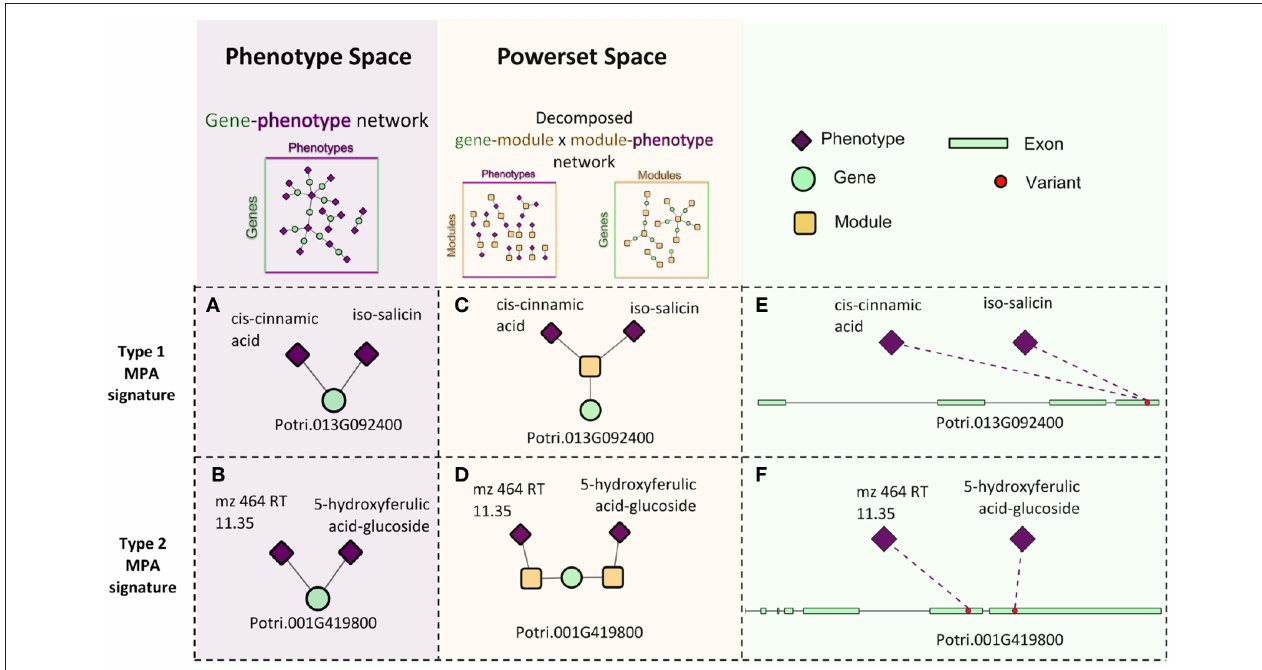
FIGURE 10 | Signature decomposition example. Two genes, Potri.013G092400 (A) and Potri.001G419800 (B) have the same surrounding network topology in the GP network in that they are both connected to two phenotypes. Projecting the genes into powerset space through MPA decomposition of the GP network indicates that they exhibit different MPA signatures in that Potri.013G092400 exhibits a type 1 MPA signature (C) , containing a SNP associating with two phenotypes (E) and Potri.001G419800 exhibits a type 2 MPA signature. (D) containing two SNPs, each with a different phenotype association (F)